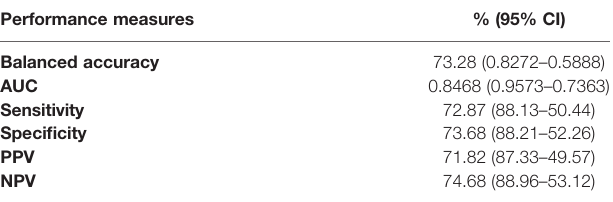
TABLE 4 | Final naïve Bayes model performance